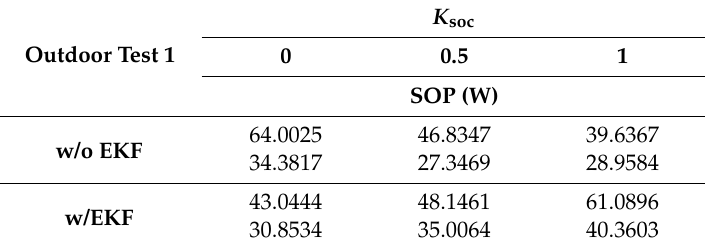
Table 5. Outdoor test result (0 kg payload).